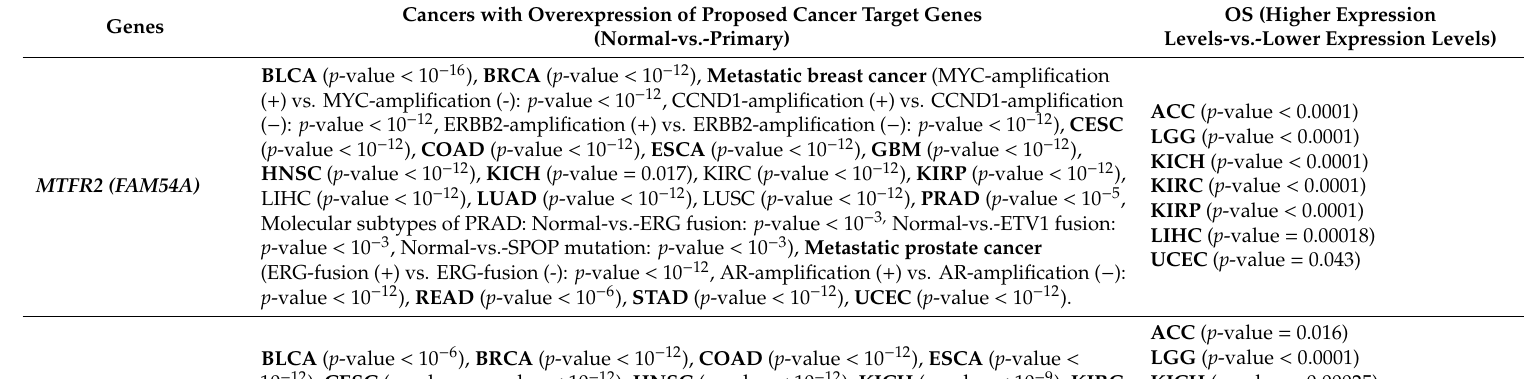
Table 3. Statistically significant overexpression of di ff erent proposed target genes in most common cancers. Cancers with Overexpression of Proposed Cancer Target Genes Genes (Normal-vs.-Primary)